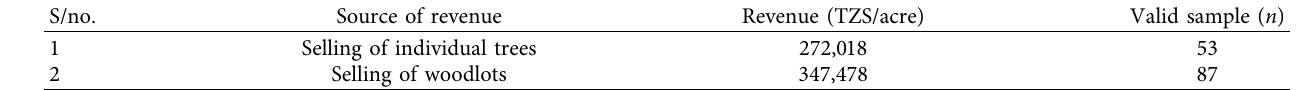
Table 4: Revenue accrued from tree